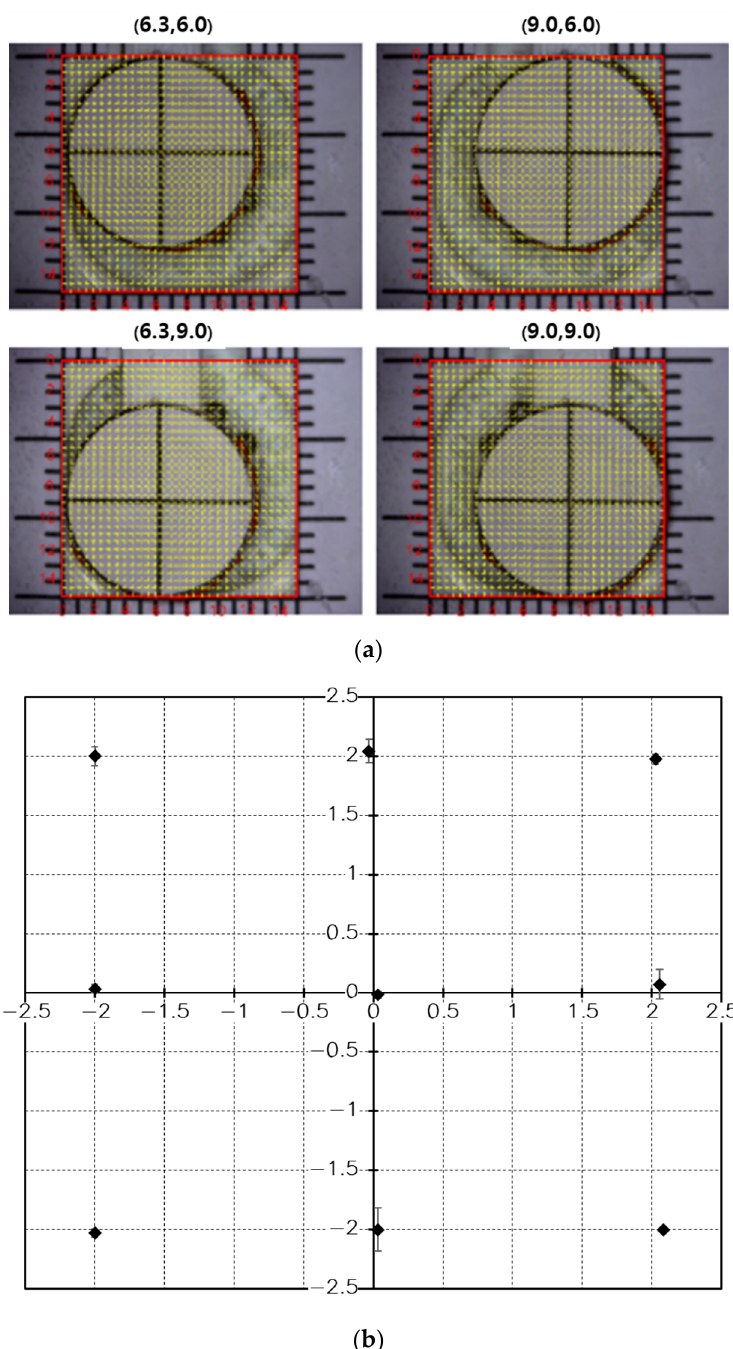
Figure 8. ( a ) Photo of the experimental procedure measuring the displacement in the lateral direc- tion. ( b ) Displacement accuracy in lateral position control without finger contact. ( b ) Displacement accuracy in lateral position control without finger